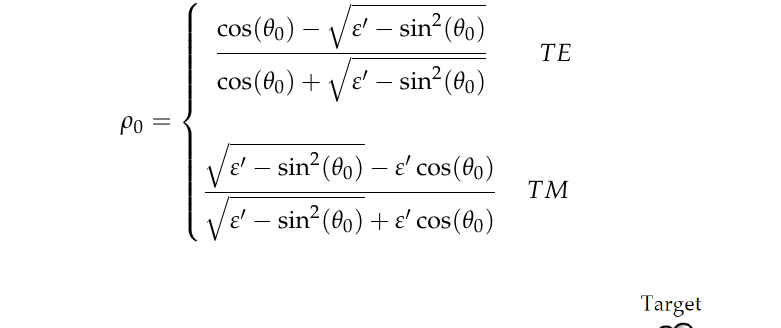
Figure 1. Four main propagation paths in a radar scenario.